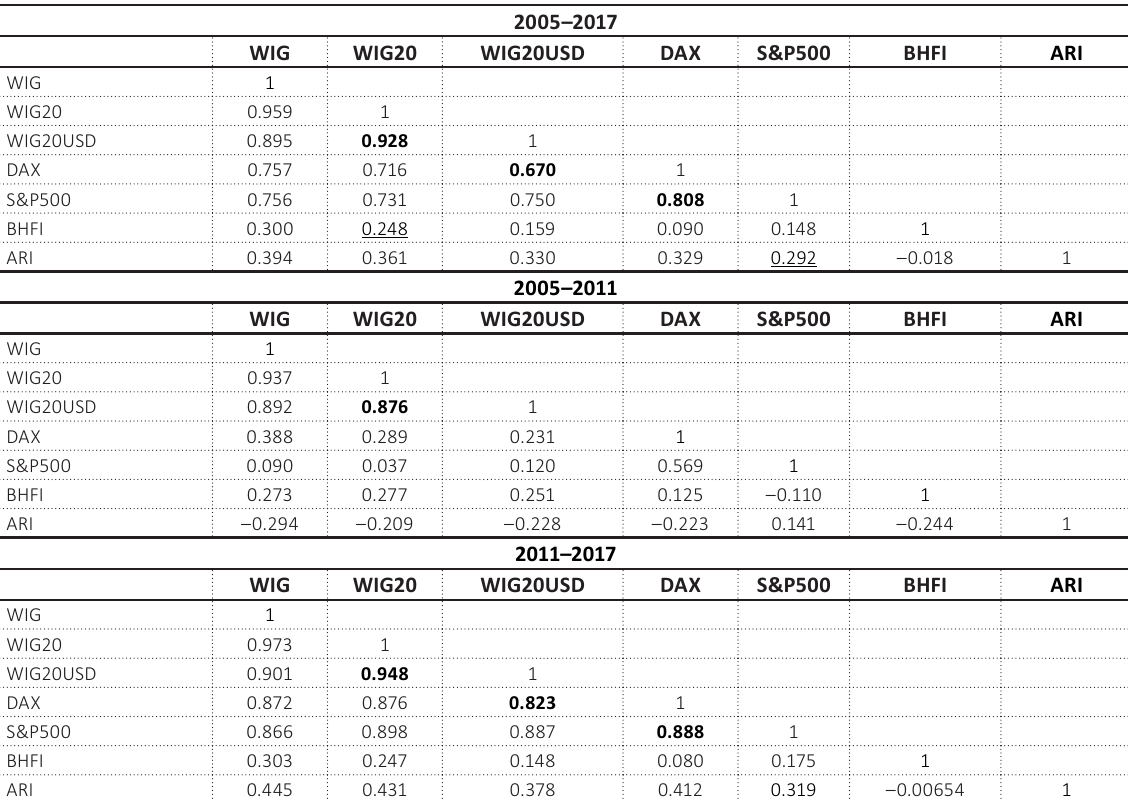
Table 6. Correlation coefficients of returns on assets for WIG, WIG20, WIG20USD, DAX, S&P500, hedge fund index BHFI and ARI in